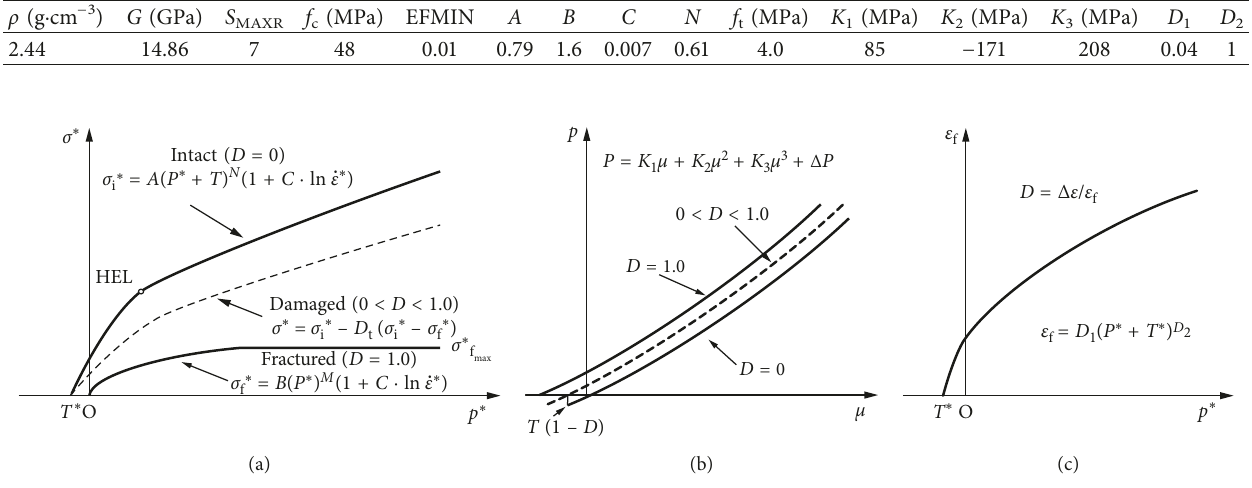
Figure 11: Description of the JH2 model: (a) strength; (b) pressure; (c)